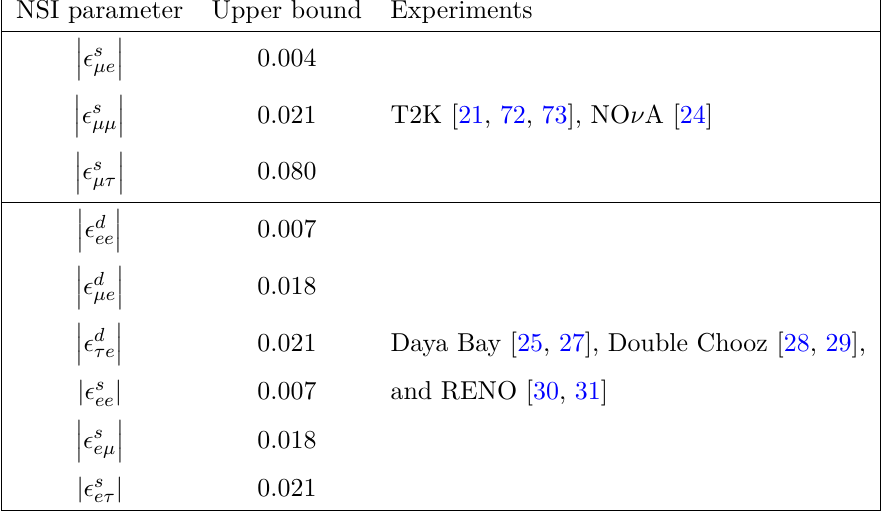
Table 4 . Upper bounds of the NSI parameters associated with the neutrino production and detec- tion. All constraints are given at 95%